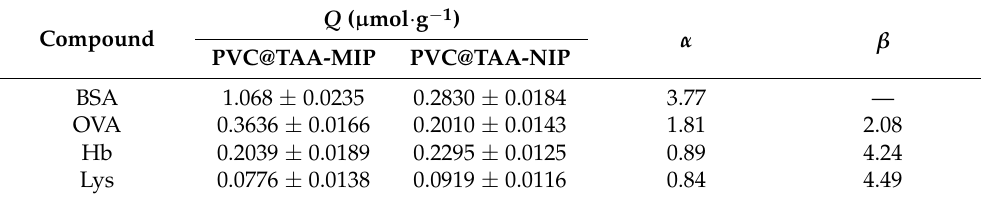
Table 1. Imprinting efficiencies and selectivity coefficients of PVC@TAA-MIP and PVC@TAA-NIP toward BSA in absence of